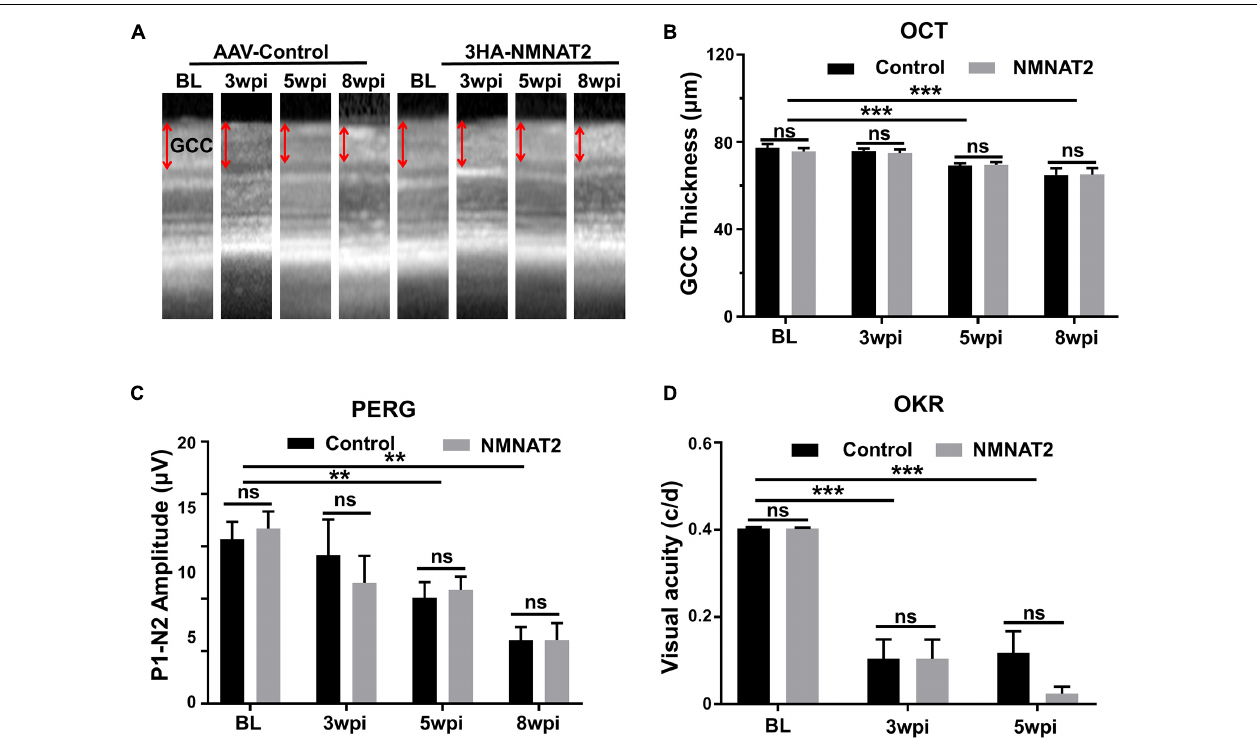
FIGURE 3 | Longitudinal in vivo studies show that nicotinamide mononucleotide adenylyltransferases 2 (NMNAT2) provides neither morphological nor visual functional protection in EAE/optic neuritis. (A) Representative optical coherence tomography (OCT) images of the mouse retina at different time points after immunization in the EAE mice. GCC, ganglion cell complex, including retinal nerve fiber layer (RNFL), ganglion cell layer (GCL), and inner plexiform layer (IPL); indicated as double end arrows. BL, baseline, before immunization. (B) Quantification of GCC thickness measured by OCT at different time points after immunization in the EAE mice. n = 16 at BL to 5 wpi; n = 6 at 8 wpi. Data are presented as means ± SEM, *** p < 0.001, one-way ANOVA with Tukey’s multiple comparisons test. Comparison of NMNAT2-injected eyes and contralateral control eyes injected with control AAVs, ns, no significance, paired two-tailed t -test. (C) Quantification of P1–N2 amplitude of PERG at different time points. n = 11 at BL to 5 wpi; n = 6 at 8 wpi. Data are presented as means ± SEM, *** p < 0.001, one-way ANOVA with Tukey’s multiple comparisons test. Comparison of NMNAT2-injected eyes and contralateral control eyes injected with control AAVs, ns, no significance, paired two-tailed t -test. (D) Visual acuity measured by optokinetic tracking response (OKR) at different time points. c/d, cycle/degree. n = 11 at BL to 5 wpi. Data are presented as means ± SEM, ** p < 0.01, one-way ANOVA with Tukey’s multiple comparisons test. Comparison of NMNAT2-injected eyes and contralateral control eyes injected with control AAVs, ns, no significance, paired two-tailed t